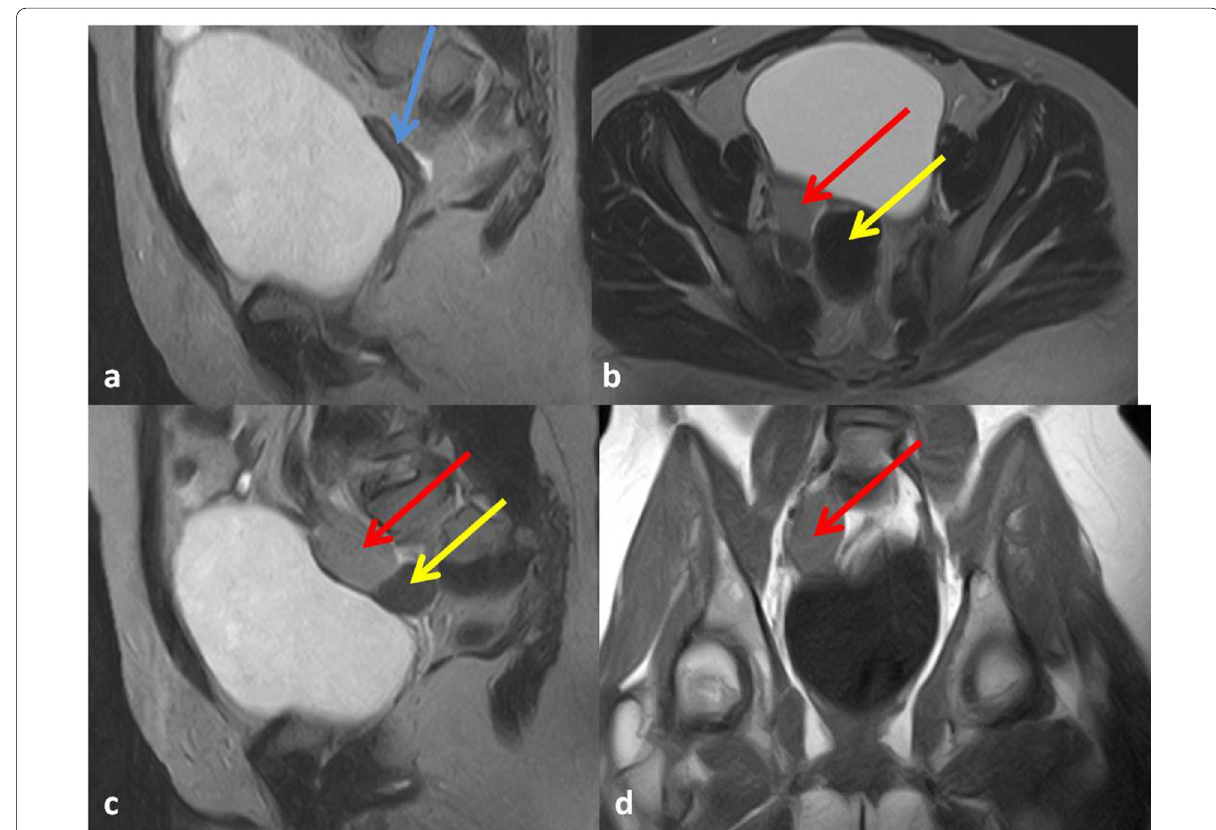
Fig. 2 Pelvic MRI examination confirmed the presence of an infantile uterus(blue arrow) ( a ) with a right adnexal lesion that showed two parts; the anterosuperior part (red arrow) elicited isointense signal in T1 and T2 and the posteroinferior one (yellow arrow) elicited hypointense signal in all pulse sequences ( b , c , d )